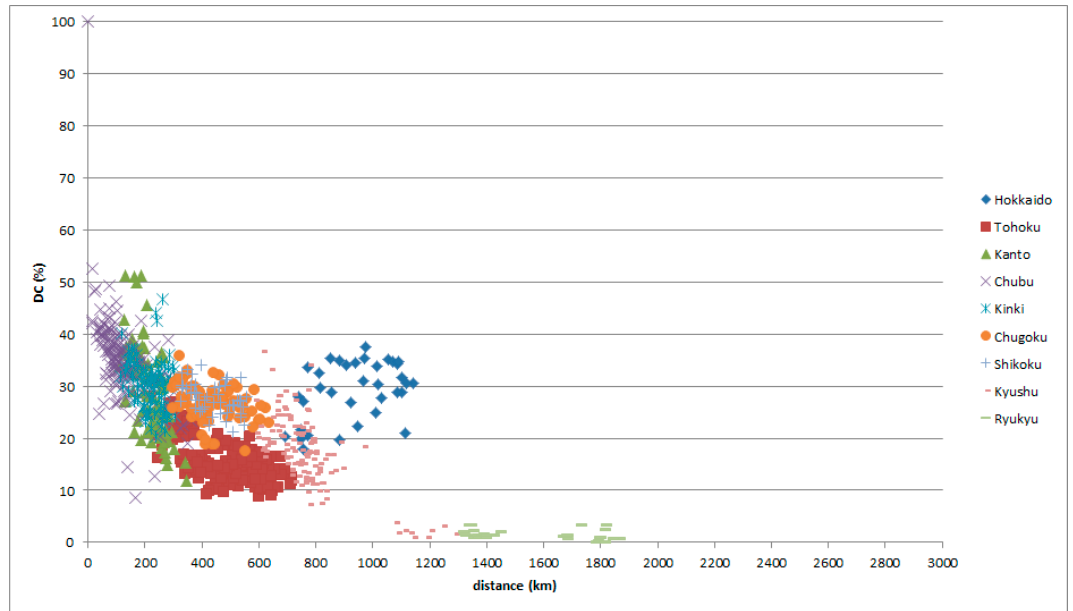
Figure 10. LAJ data with reference place in Tokaitosan, classified by comparison place.